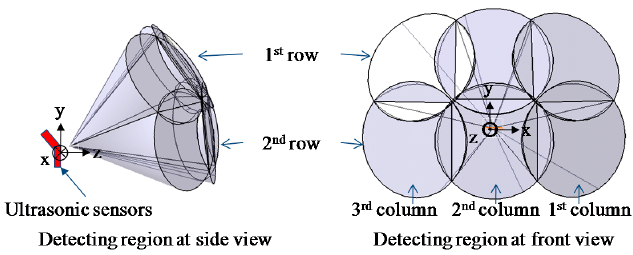
Figure 5. Sensing area of the six ultrasonic sensors.